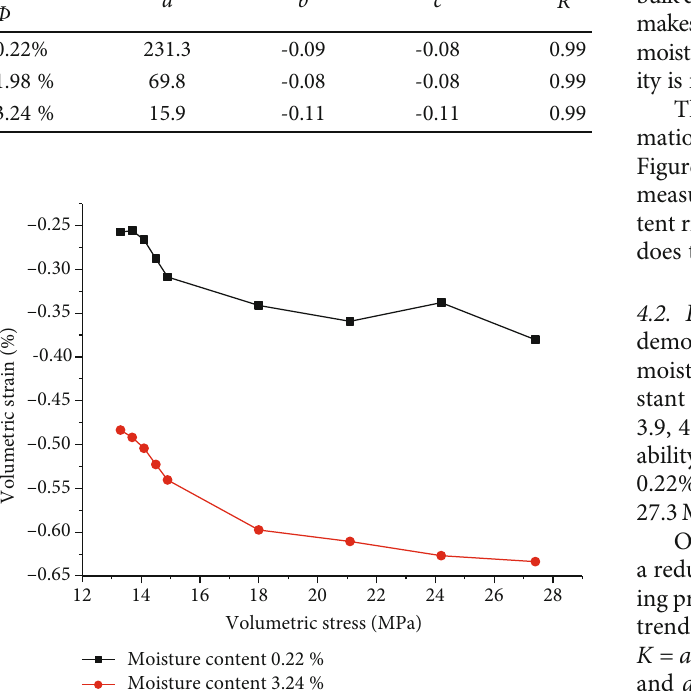
Table 2: Fitting coe ffi cients of K - σ